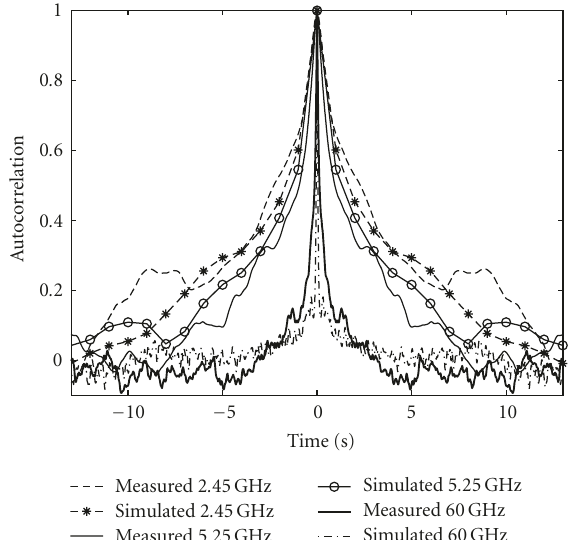
Figure 18: AFDs of measured (dry leaved deciduous trees (Site 1)) and simulated (using the new model) signals at 2.45, 5.25, and 60GHz during high ( w m = 5 m/s) wind speed conditions.